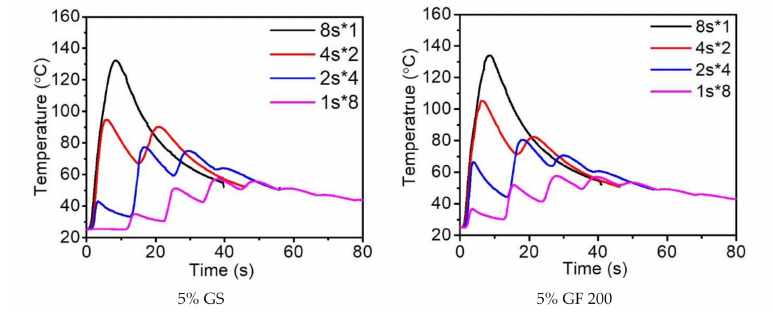
Figure 7. Effects of filler type and curing strategies on the reaction heat